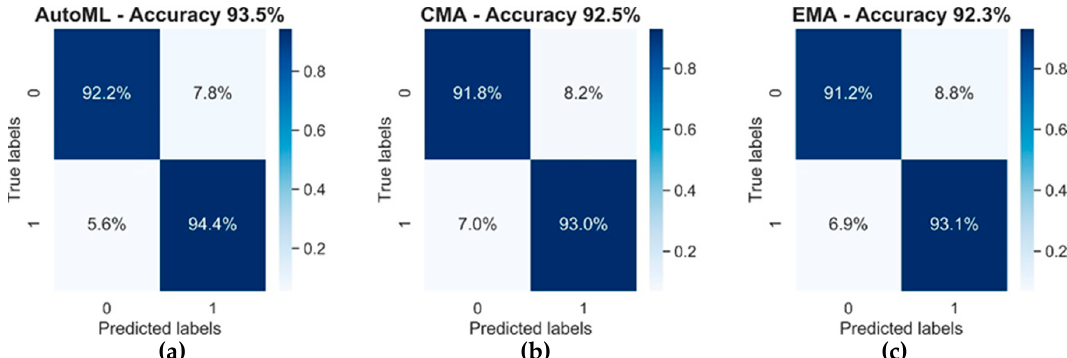
Figure 1. Confusion matrices and accuracy of all 3 models on the training dataset. The labels indicate predicted and actual vehicle availability. AutoML, automated machine learning ( a ); CMA, cumulative moving average ( b ); EMA, exponential moving average ( c ).